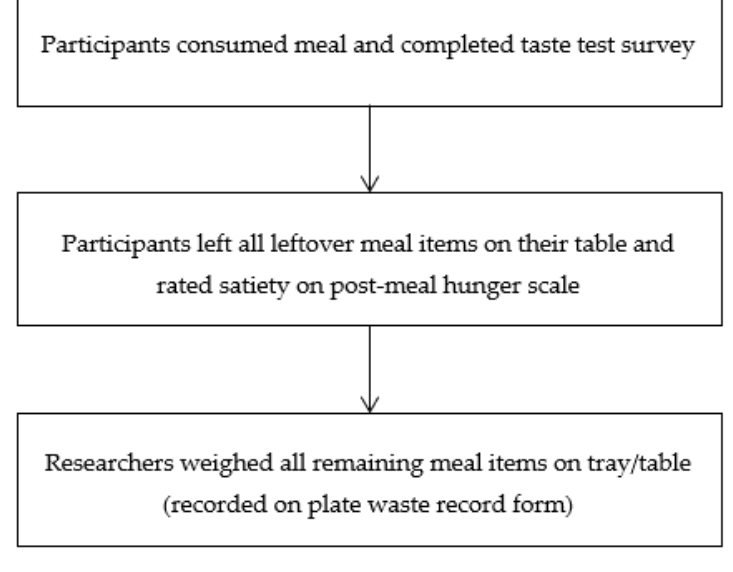
Figure 2. Meal session flow chart.